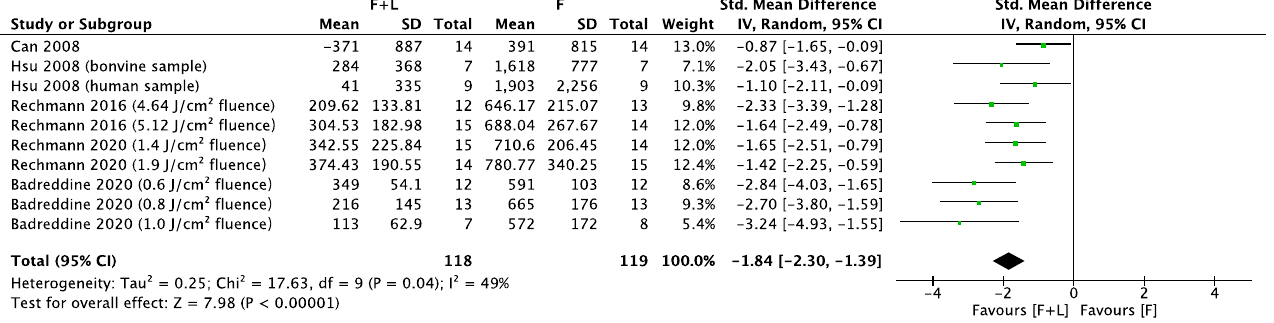
Figure 2. Meta-analysis comparing the effect of the treatment combining fluoride and laser (F + L) and treatment using only fluoride (F) on mineral loss.